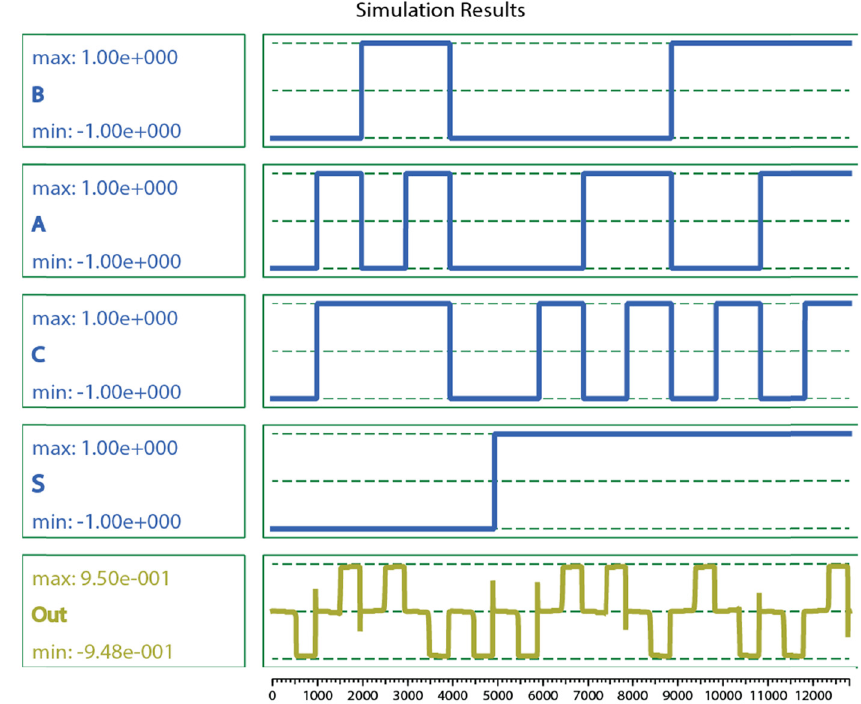
Figure 11: Simulation results of the proposed